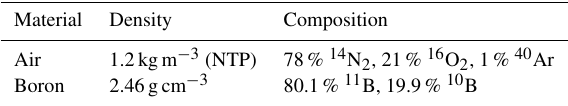
Table 2. Examples of the composition of the material “dry air” (at normal temperature and pressure (NTP)) and a neutron converter. Material Density